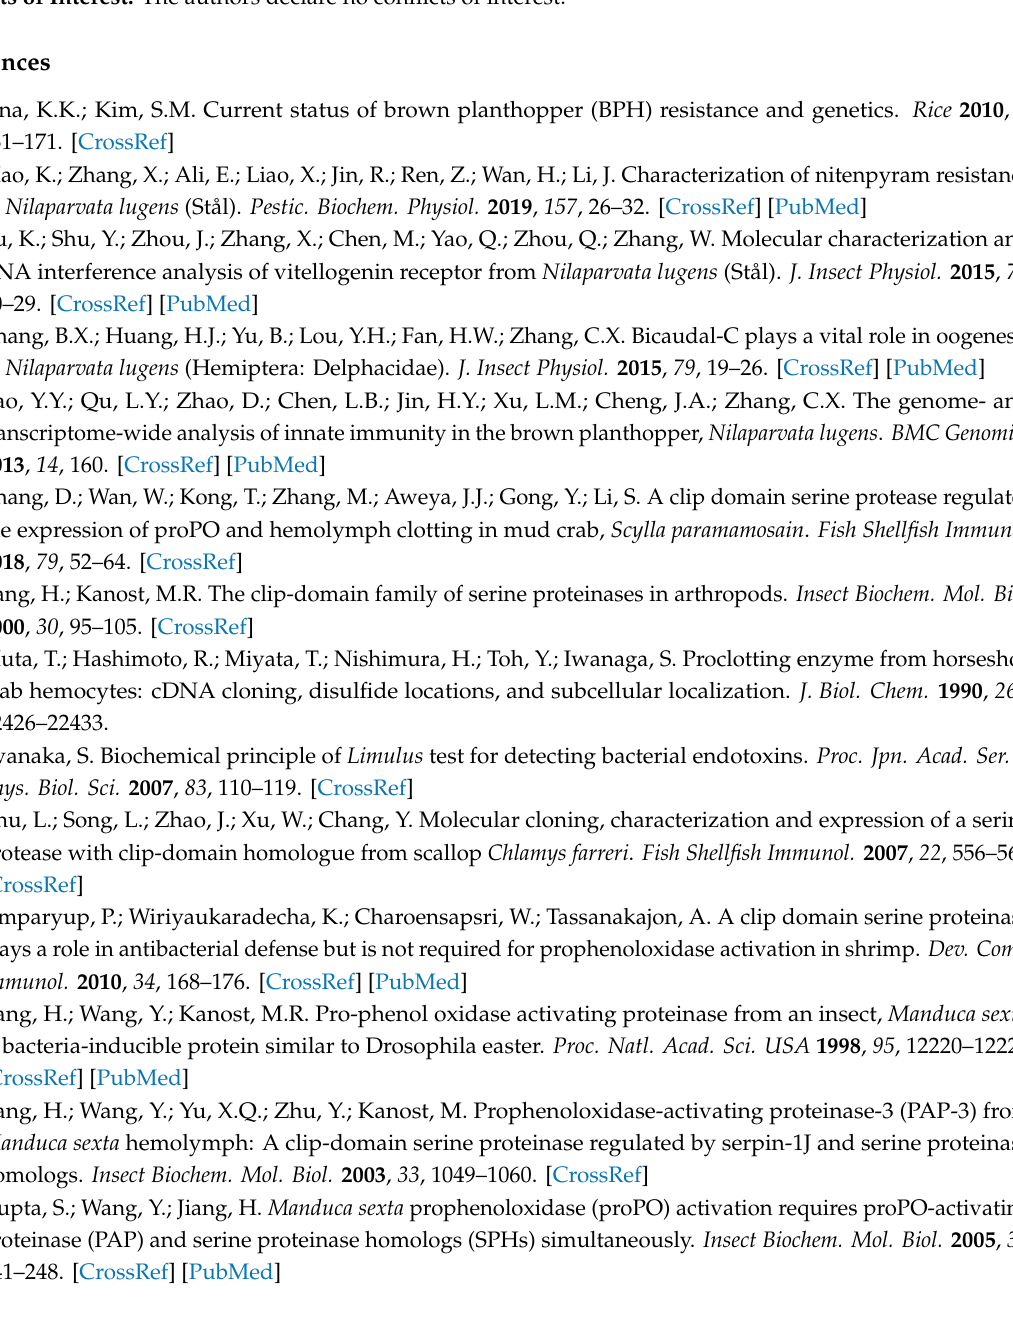
Figure S1: Specificity of anti- Nl PCE3 antibody analysed by western blot, Figure S2: Amino acid sequence comparison of clip-SPs, Figure S3: Amino acid sequence comparison of Nl